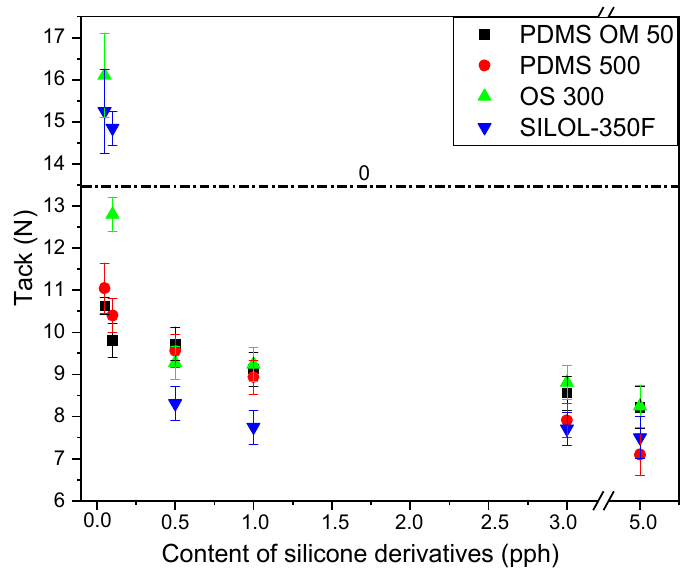
Figure 4. The maximum work temperature of silicone pressure sensitive adhesives with different silicone derivatives addition.